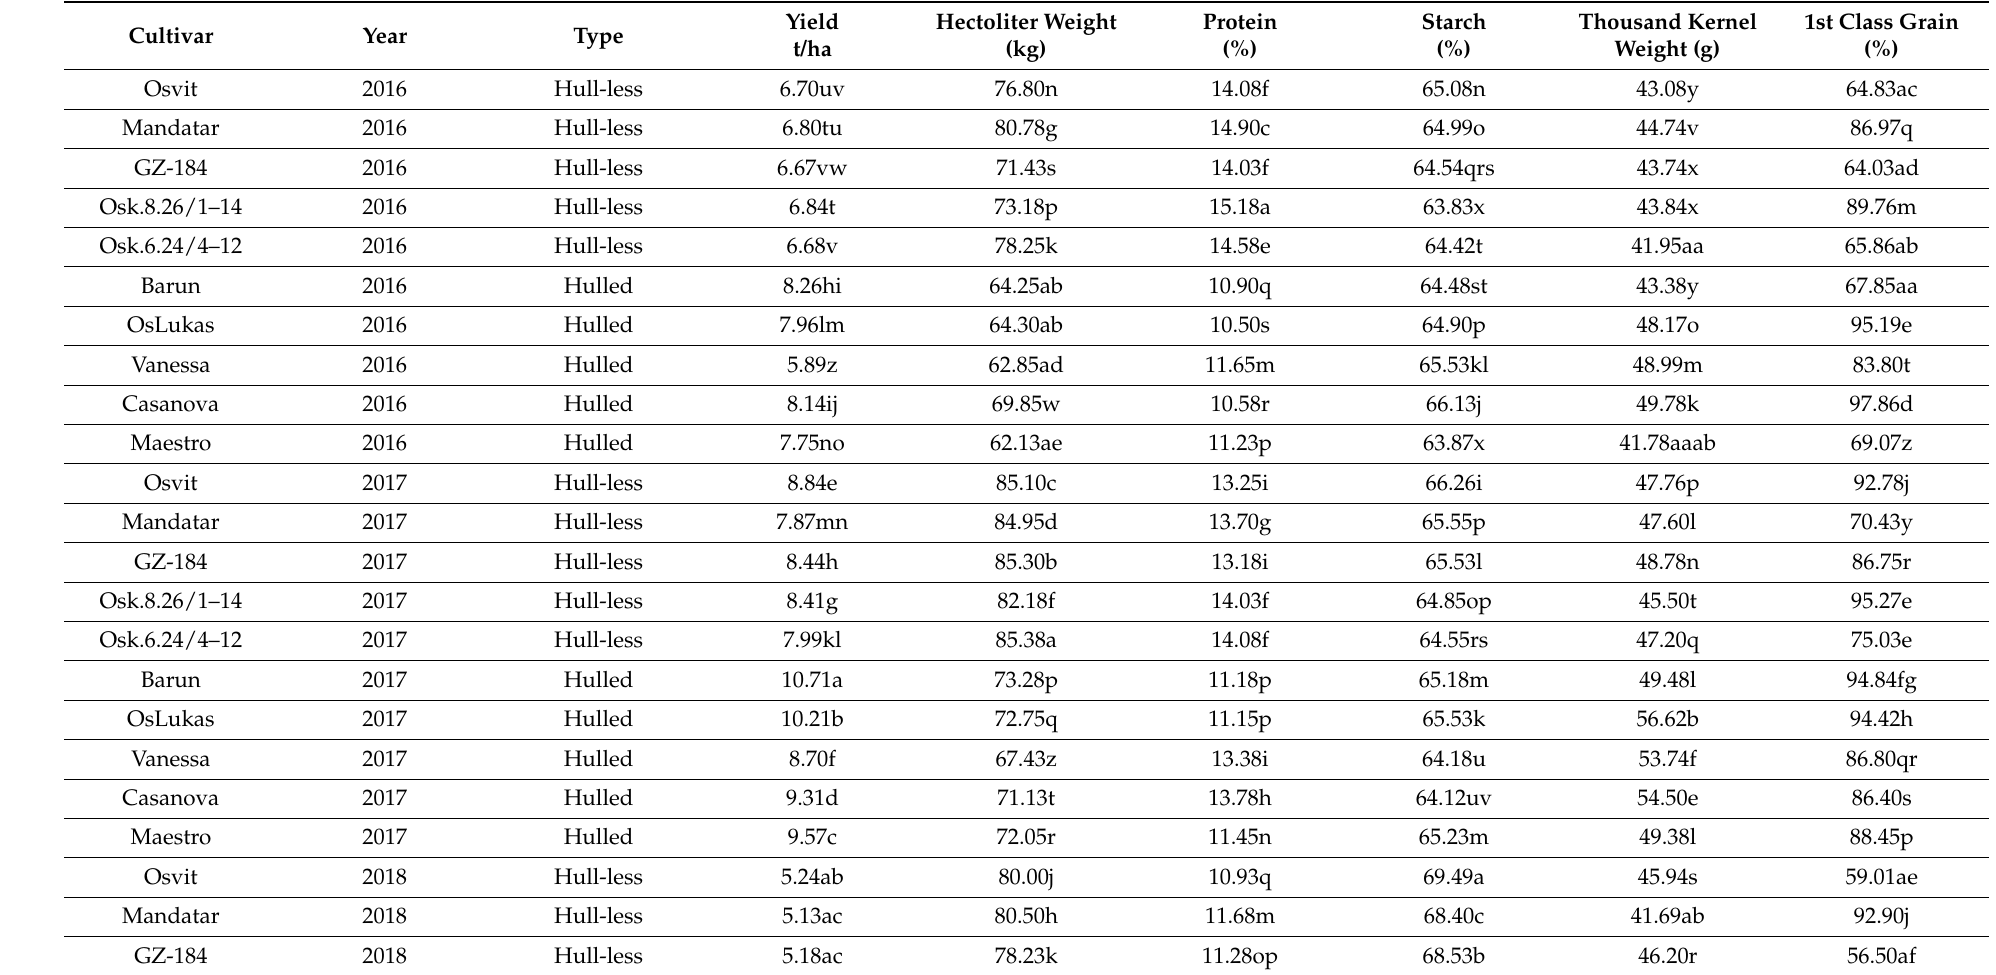
Table 1. Barley quality